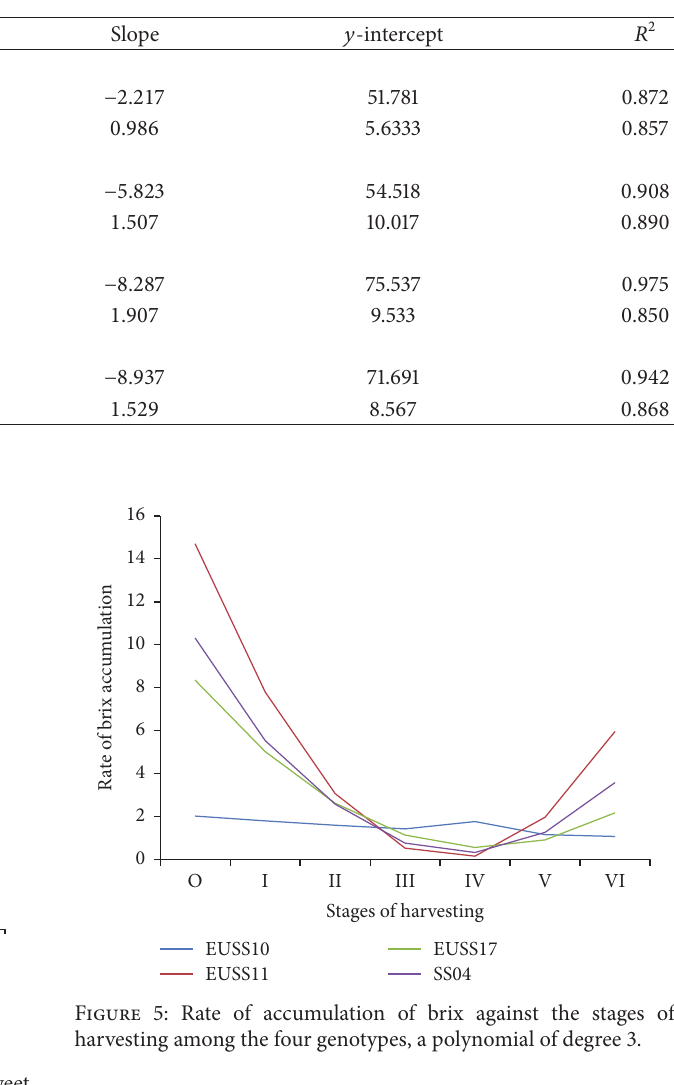
Figure 4: Effect of harvesting stage on brix (%) of four sweet sorghum genotypes in western part of Kenya.